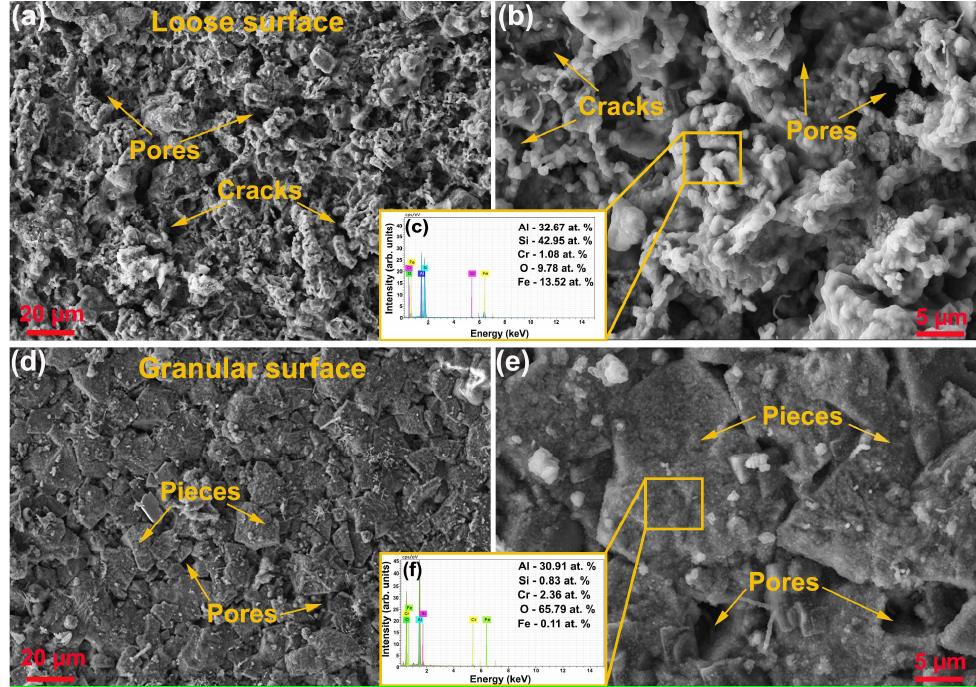
Figure 3. Surface SEM images with the corresponding EDS spectra of all samples after 100 h hot-salt corrosion tests: ( a – c ) M1; ( d – f ) M2.